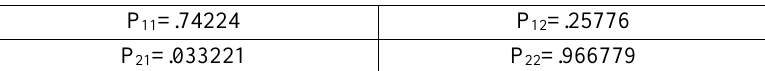
Table 11: Results of transfer matrix between regimes (authors’ calculations)